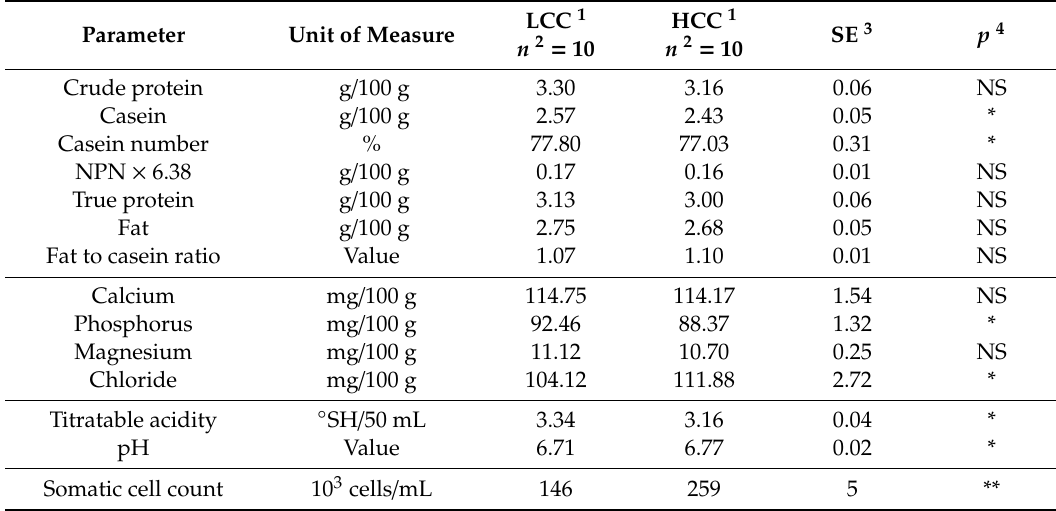
Table 1. Chemical composition and physicochemical properties parameters of vat milk with less than 400,000 (Low Cell Count (LCC)) and more than 400,000 cells / mL (High Cell Count (HCC)) (least square mean values ± standard